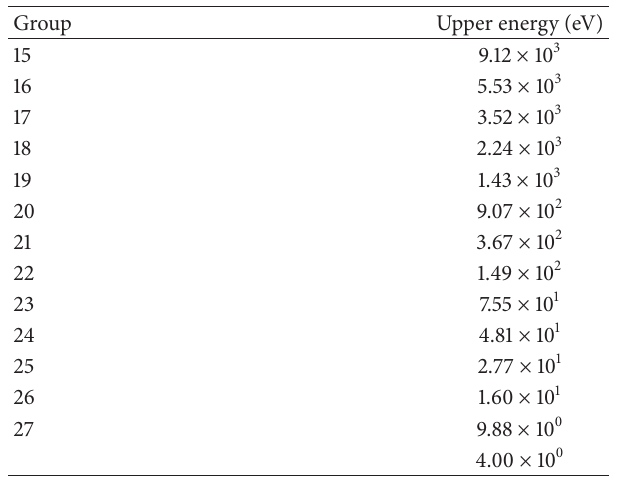
Table 1: WIMS 69-group library resonance group boundaries.